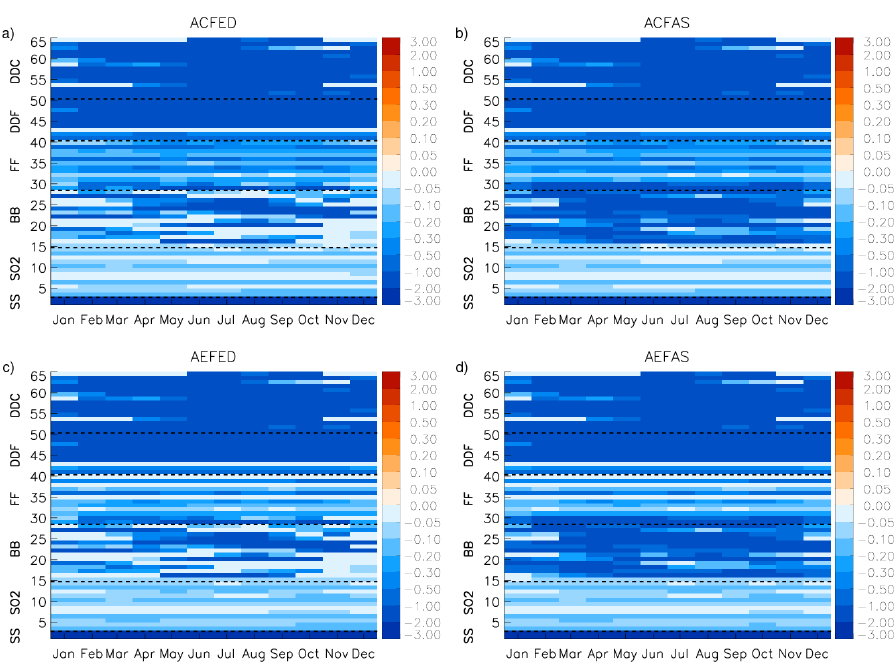
Fig. 9. Difference in monthly mean errors (analysis − first guess) for (a) ACFED, (b) ACFAS, (c) AEFED and (d) AEFAS. The number of rows in the figure corresponds to the number of elements in the control vector. Each row corresponds to the seasonal cycle of the difference between analysis and first guess error of a given emission flux and region illustrated in Fig. 1. DDF and DDC correspond to the fine and coarse modes of DD, respectively. The rows between different species are separated by black discontinuous lines. The red/blue colours indicate positive/negative differences.